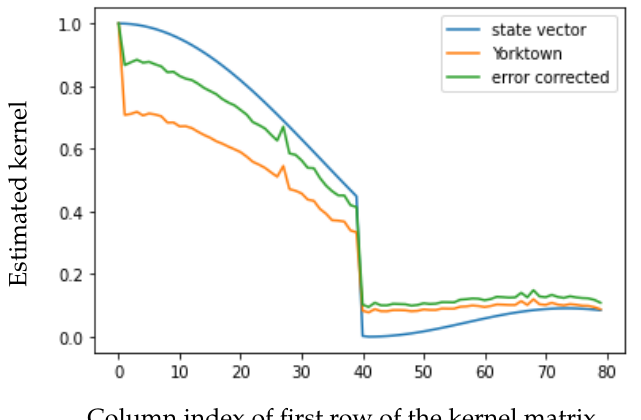
Column index of first row of the kernel matrix Figure 3. First row of the kernel matrix, estimated from state vector simulation and from the Yorktown quantum computer, as well as the corresponding error-mitigated